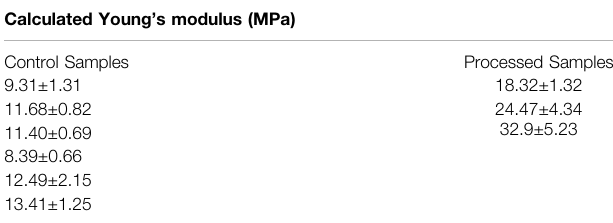
TABLE 1| CalculatedYoung ’ smodulusofunprocessedandprocessed samples.